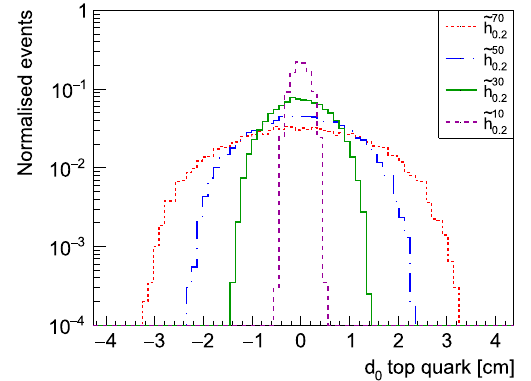
Fig. 28 Track multiplicity associated with displaced vertices in the ˜ h 2 -like case